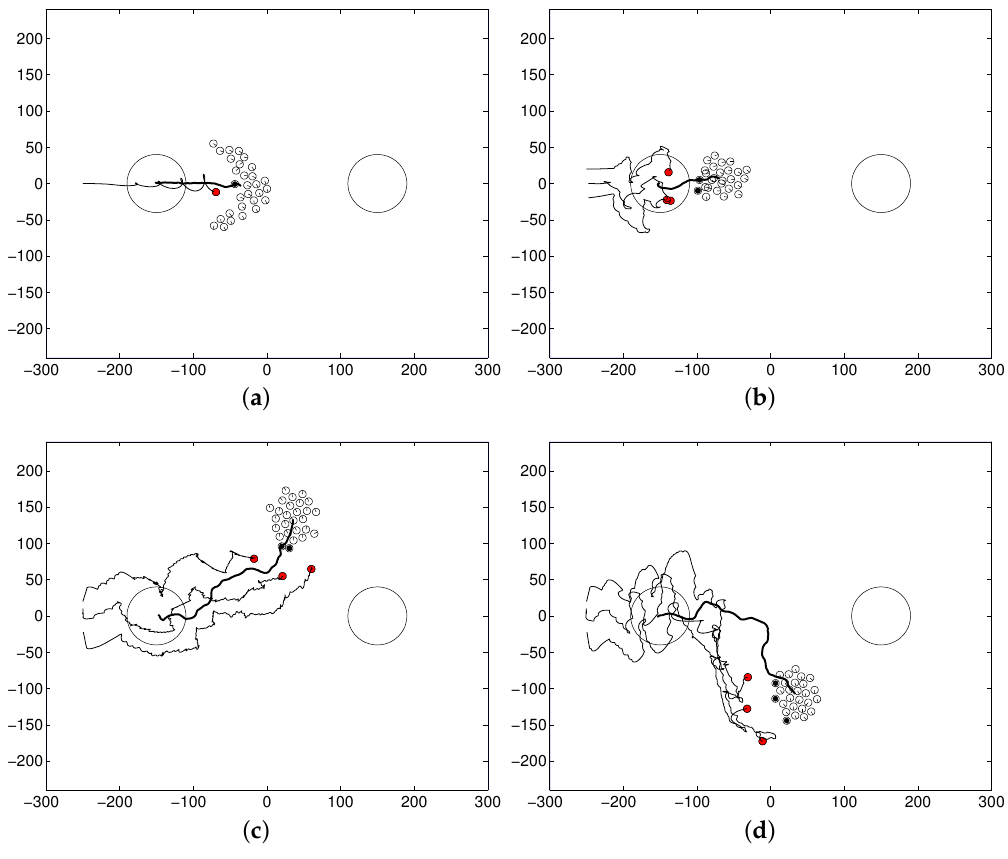
Figure 10. Examples of agent behaviors missing the goal: ( a ) the flock of sheep agents is scattered; ( b ) arc formation is not generated; ( c ) steering agents move in the wrong direction; and ( d ) the flock is not controlled by the steering